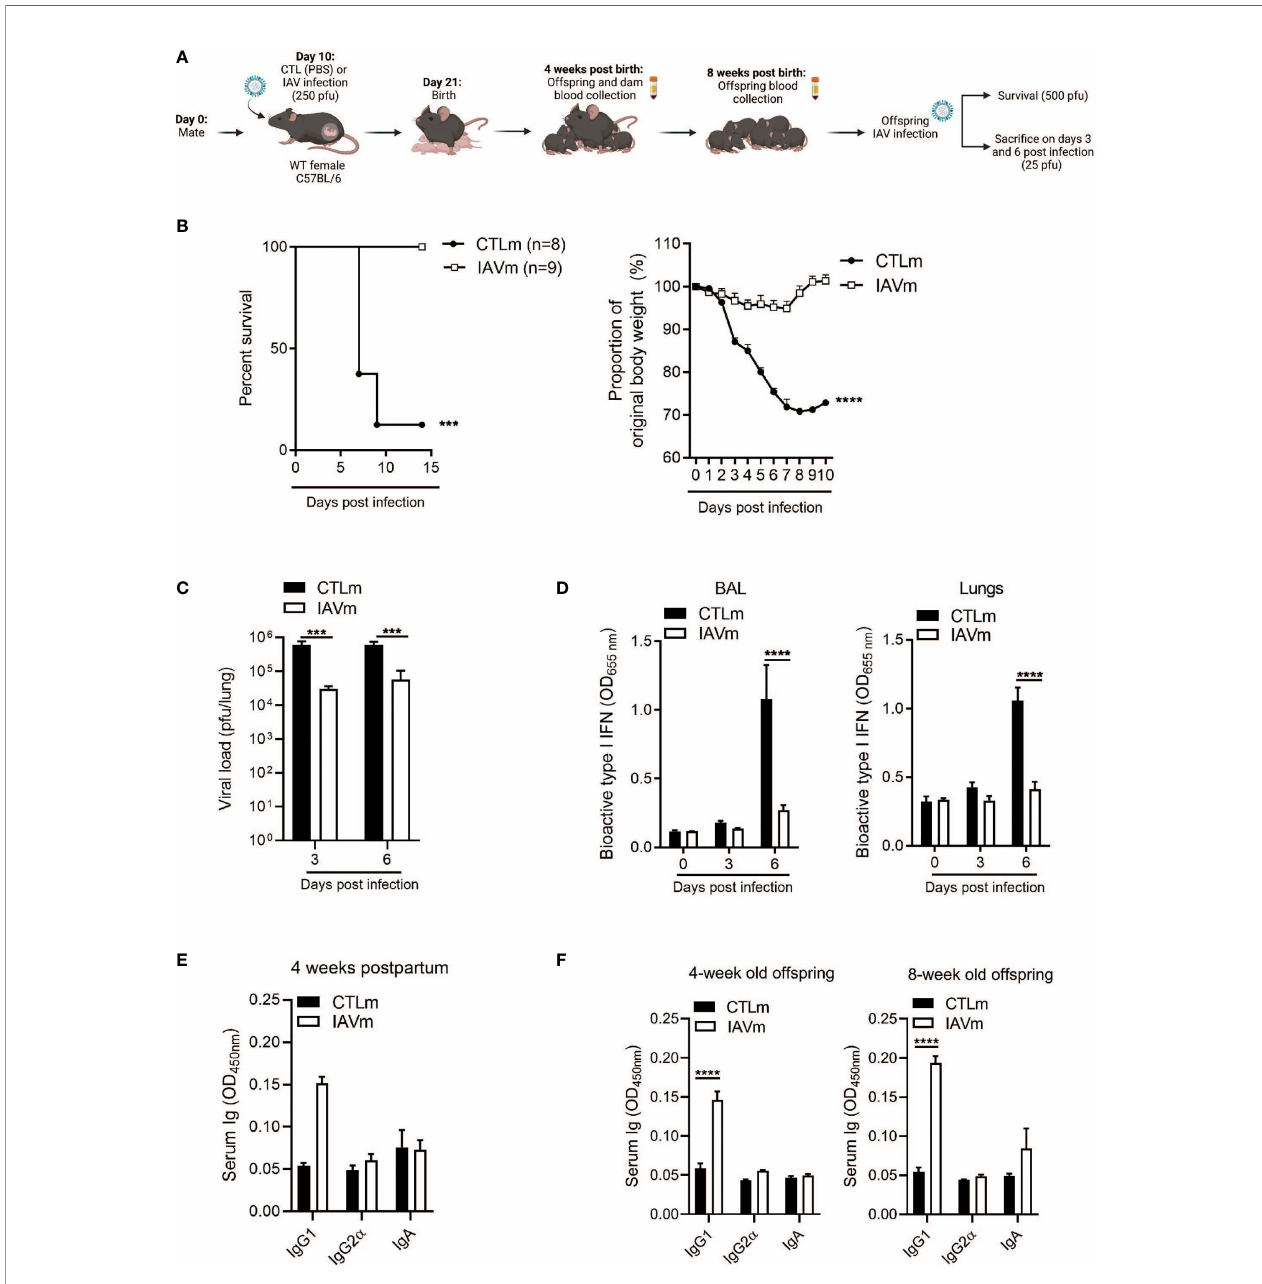
FIGURE 1 | Maternal IAV-infection confers IgG1-mediated resistance to offspring. (A) Schematic representation of experimental design. 8 – 10-week-old C57BL/6 females were given PBS (CTLm; n=2 dams) or infected with 250 pfu A/Puerto Rico/8/34 (PR8) (IAVm; n=3 dams) intranasally on E10. Created with BioRender.com. (B) Survival curve and morbidity graph following lethal infection (500 pfu PR8) of 6-week-old females born to control dams (n=8 offspring) or IAV-infected dams (n=9 offspring). (C) Kinetics of viral load in whole lung homogenates by MDCK plaque assay and (D) type I IFNs in BALF and lungs by B16 assay of 6-week-old offspring infected with 25 pfu PR8 (n=3-5 offspring). (E) Serum antibody levels of control and IAV-infected dams 4 weeks postpartum (n=2). (F) Serum antibody levels of naïve offspring at 4 weeks and 8 weeks of age prior to secondary infection (n=3-4). Data pooled for male and female offspring. Two-way ANOVA ***p < 0.001, ****p < 0.0001. License acquired for schematics from